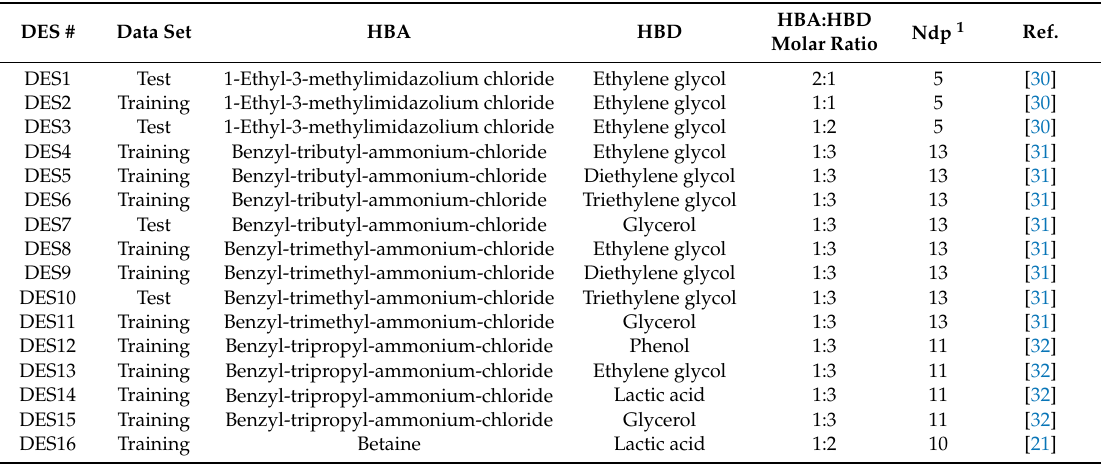
Table 1. The list of investigated deep eutectic solvents (DESs) in this study and the